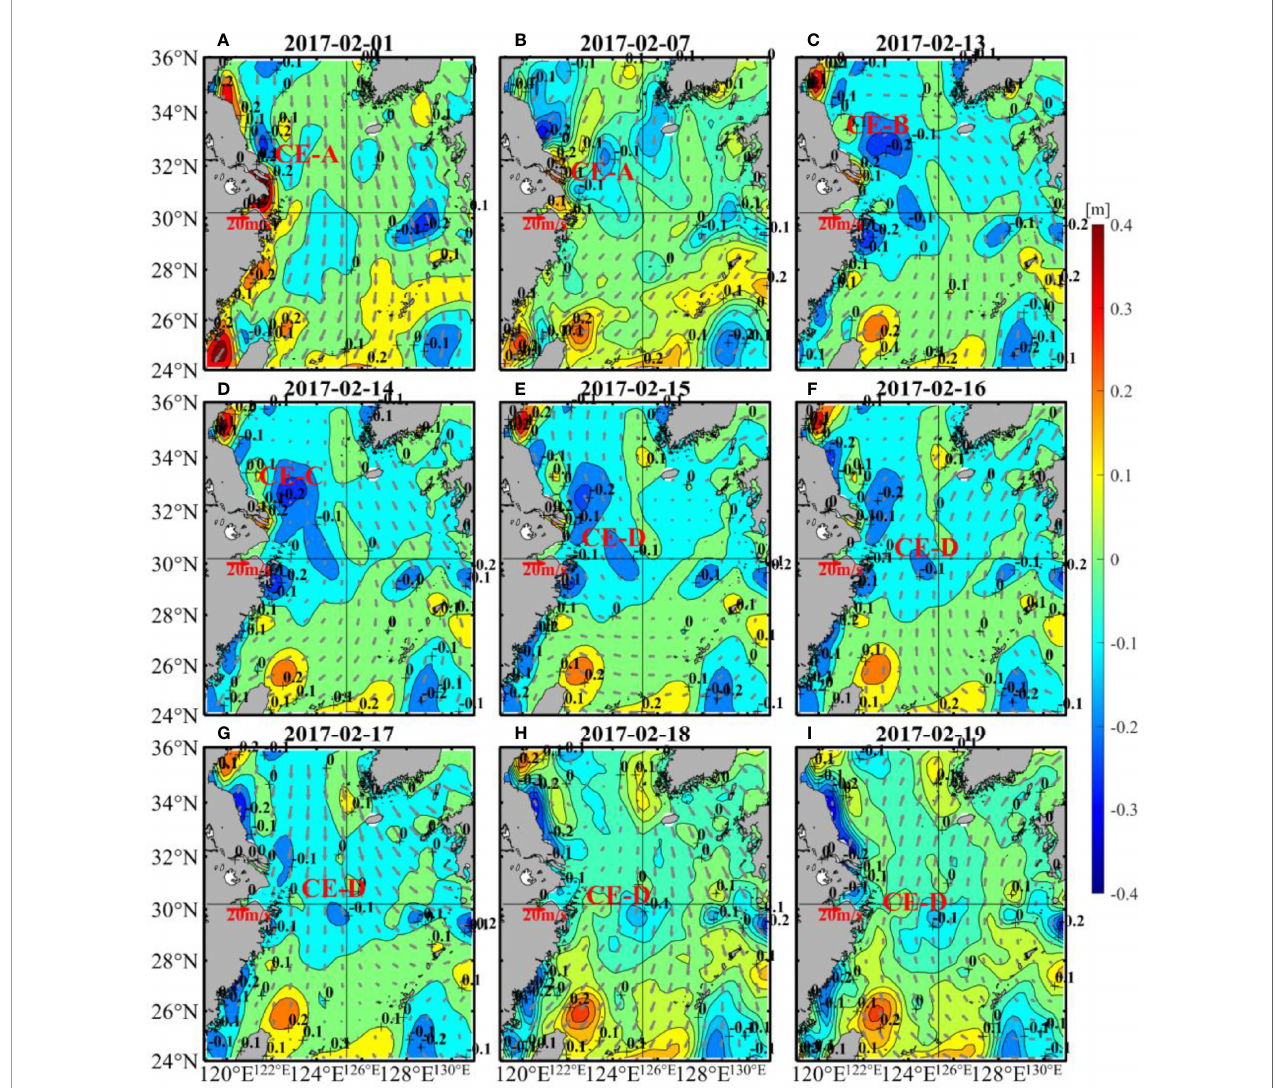
FIGURE 5 | Changes of SLA (color shading) and wind (vectors) in 1 (A) , 7 (B) , 13-19 (C – I) of February 2017. Closed contour lines of SLA are cold eddies and warm eddies, and the negative centers are cold eddies. The SLA data were obtained from CMEMS and the wind data were from